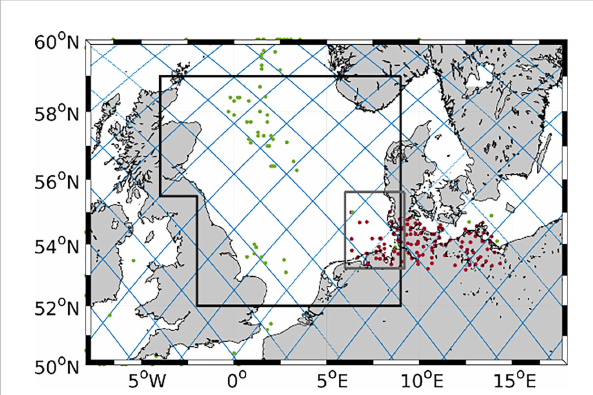
FIGURE 1 Positions of the observational data. Red dots are the DWD stations, green dots indicate the GTS stations, and the blue lines are the Jason-3 tracks. The grey box indicates the area of the German Bight and black box the area of the North Sea.